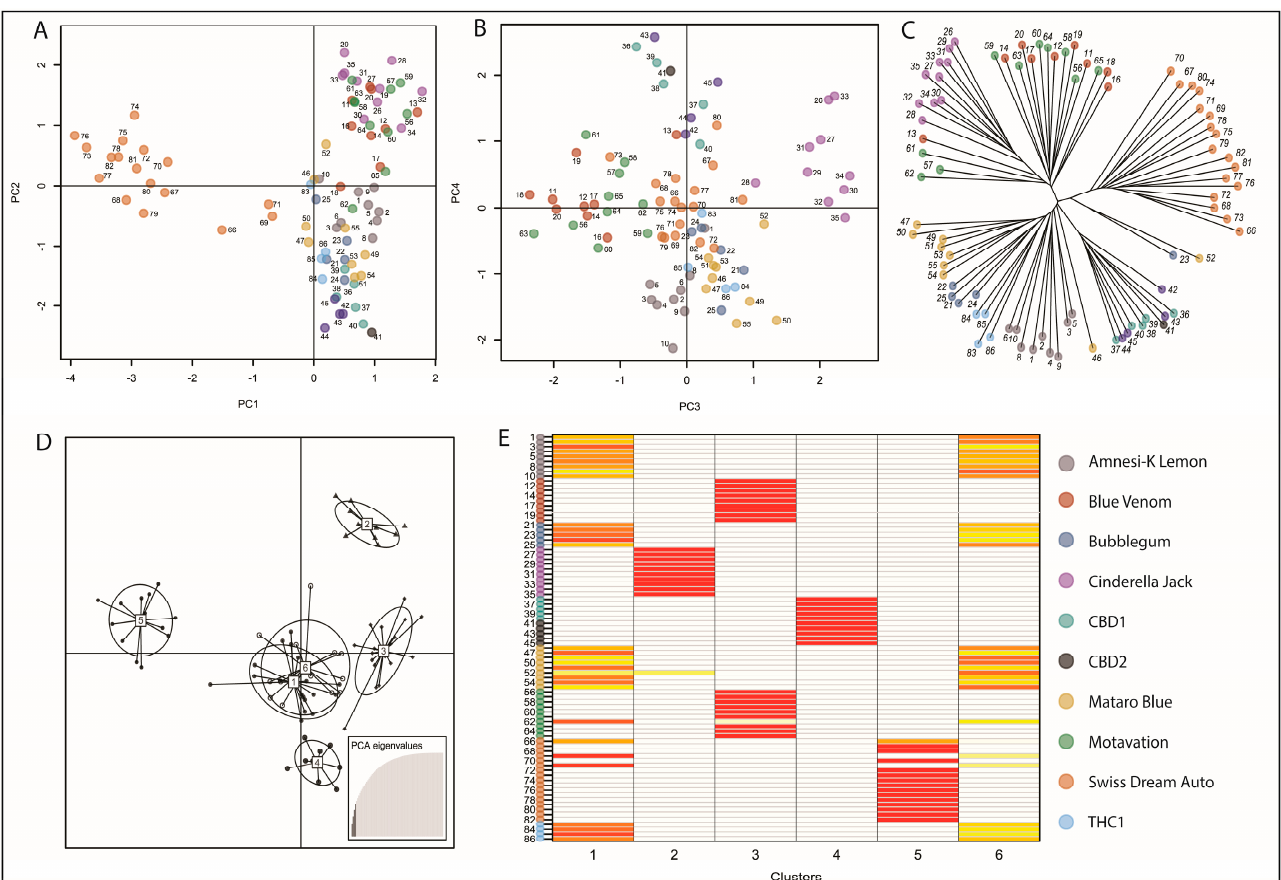
Figure 3. PCA and DAPC of variants found in genes identified to encode catalytic enzymes of the cannabinoid biosynthesis pathway. ( A ) Plot of the first 2 PC vectors; PC1 and PC2 ( B ) Plot of PC vectors, PC3 and PC4 ( C ) Unrooted phylogenetic tree demonstrated 6 discreet clusters based on PCA, which are also observed in the ( D ) DAPC plot. ( E ) Clusters 1 and 6 display extensive overlap, which is similarly observed in the assignplot where red shaded rectangles indicate high probability of correct assignment to each cluster, with the shading color spectrum passing through orange and yellow to white, representing a gradual reduction in probability. Color code indicates dot color and variety relationship throughout.